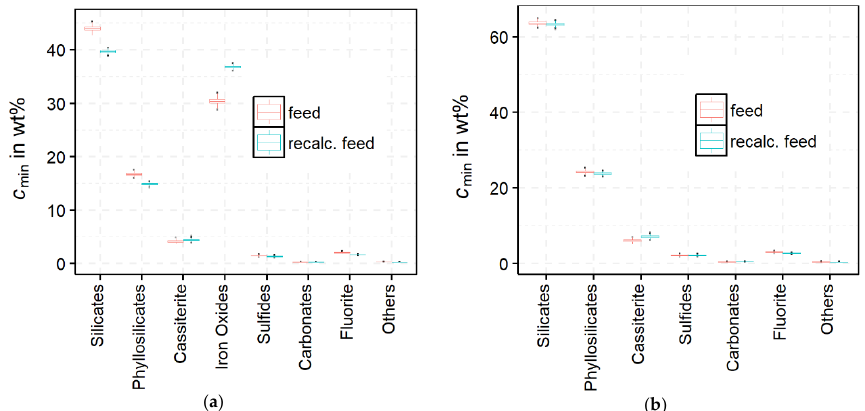
Figure 4. Comparison of mineral contents of real feed and recalculated feed based on the three products from magnetic separation ( a ) for all mineral groups; ( b ) without iron oxides closed to 100 wt%) (N = particle number of MLA sample; M = 1000). The median marks the mid-point of the data and is shown by the line that divides the box into two parts. Half the values are larger than or equal to this value and half are less. The middle “box” represents the middle 50% of values for the group. The range of scores from lower to upper quartile is referred to as the inter-quartile range. The middle 50% of values fall within the inter-quartile range. Outliers that fall out of the boxplot range are marked by